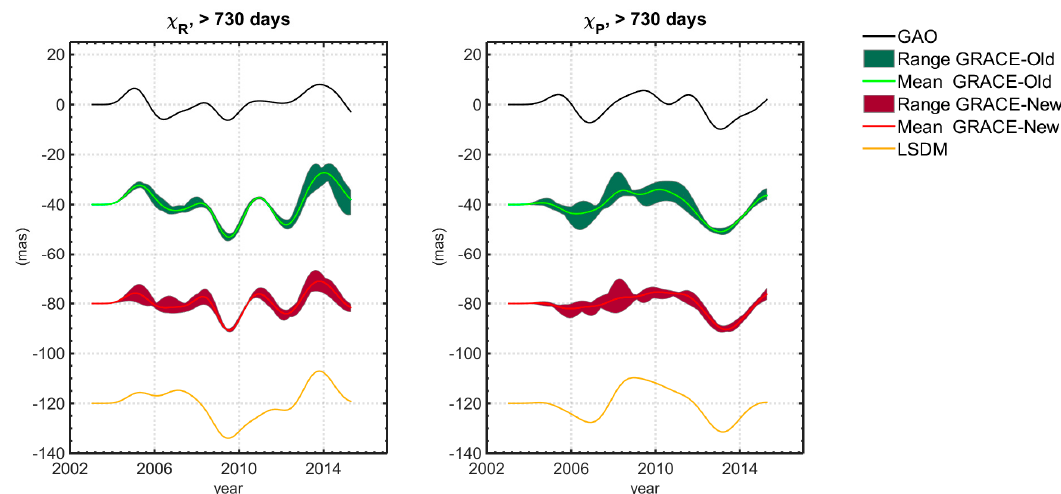
Figure 8. Comparison of mean value with ranges between minimum and maximum for χ R and χ P of long-term ( > 730 days) non-seasonal variation in HAM for old and new GRACE solutions. Time series of GAO and HAM from the LSDM are provided for comparison. For better visibility, a bias was added to various HAM in order to shift them relative to each other.